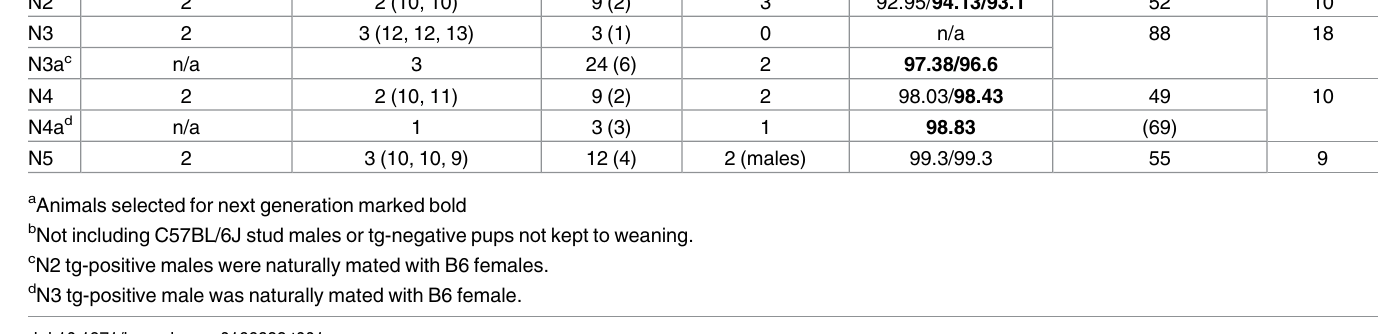
Table 1. Backcrossing Outcomes. N Females superovulated,n